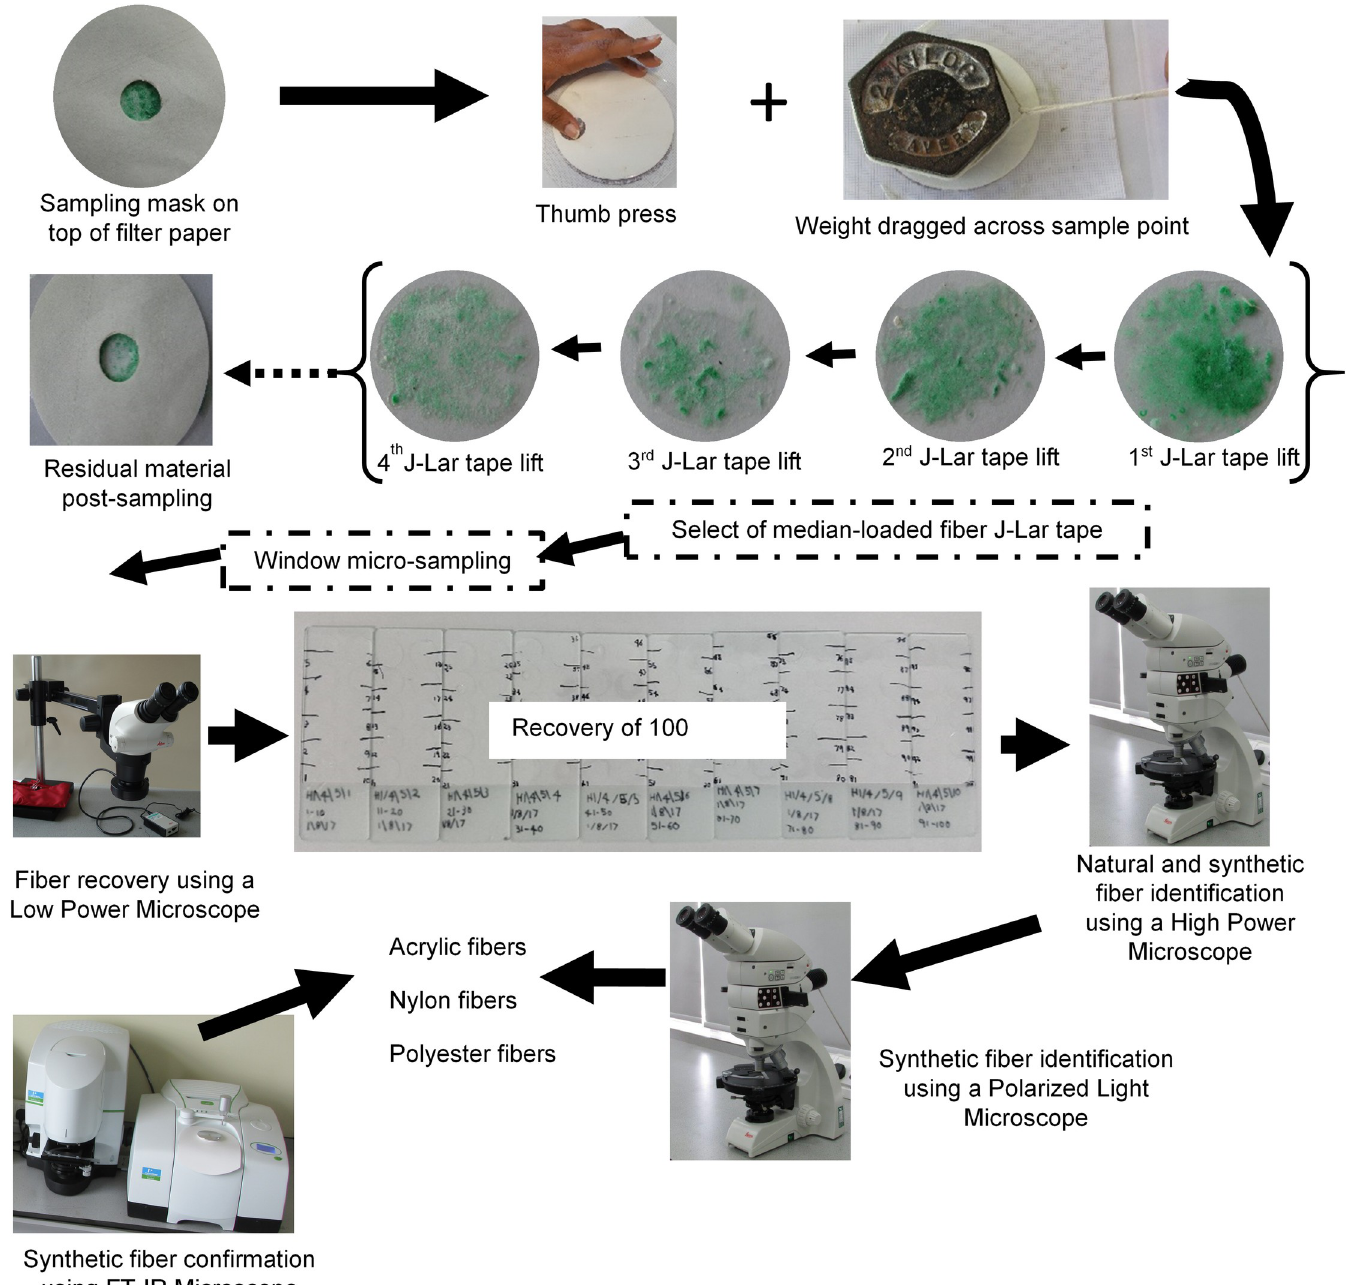
Fig 1. Systematic process for colored fiber recovery and identification. https://doi.org/10.1371/journal.pone.0233332.g001 Polarizing Light Microscopy (Ortholux, Leica, Milton Keynes, U.K.). Using visual identifica- tion of surface morphology of shape and characteristic features allowed the discrimination of fiber types e.g. ‘synthetic fibers’ (i.e. delusterant particles) from those of cotton (i.e. ribbon) and wool (i.e. scales). Further analysis of the ‘synthetic fibers’, using a Polarized Light Micro- scope (allowed generic identification of acrylic, nylon or polyester fibers. This was achieved by determining the birefringence value [29] that correlates to fiber type.